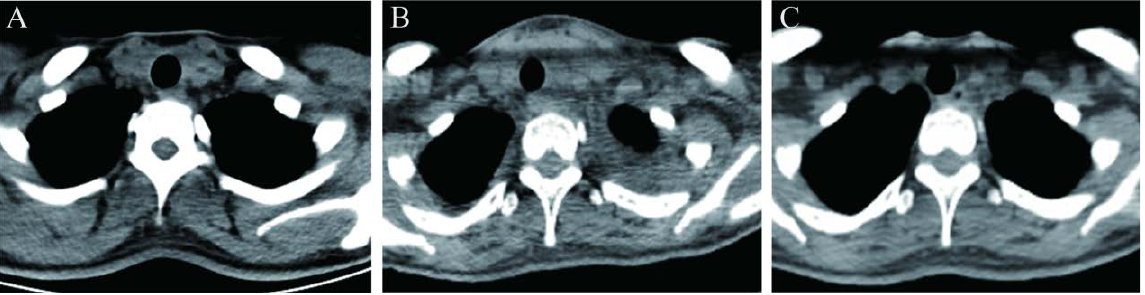
Figure 1. Neck CT images showing the remaining left thyroid lobe before 131 I administration ( A ), and 3 days ( B ) and 9 days ( C ) post 131 I administration.